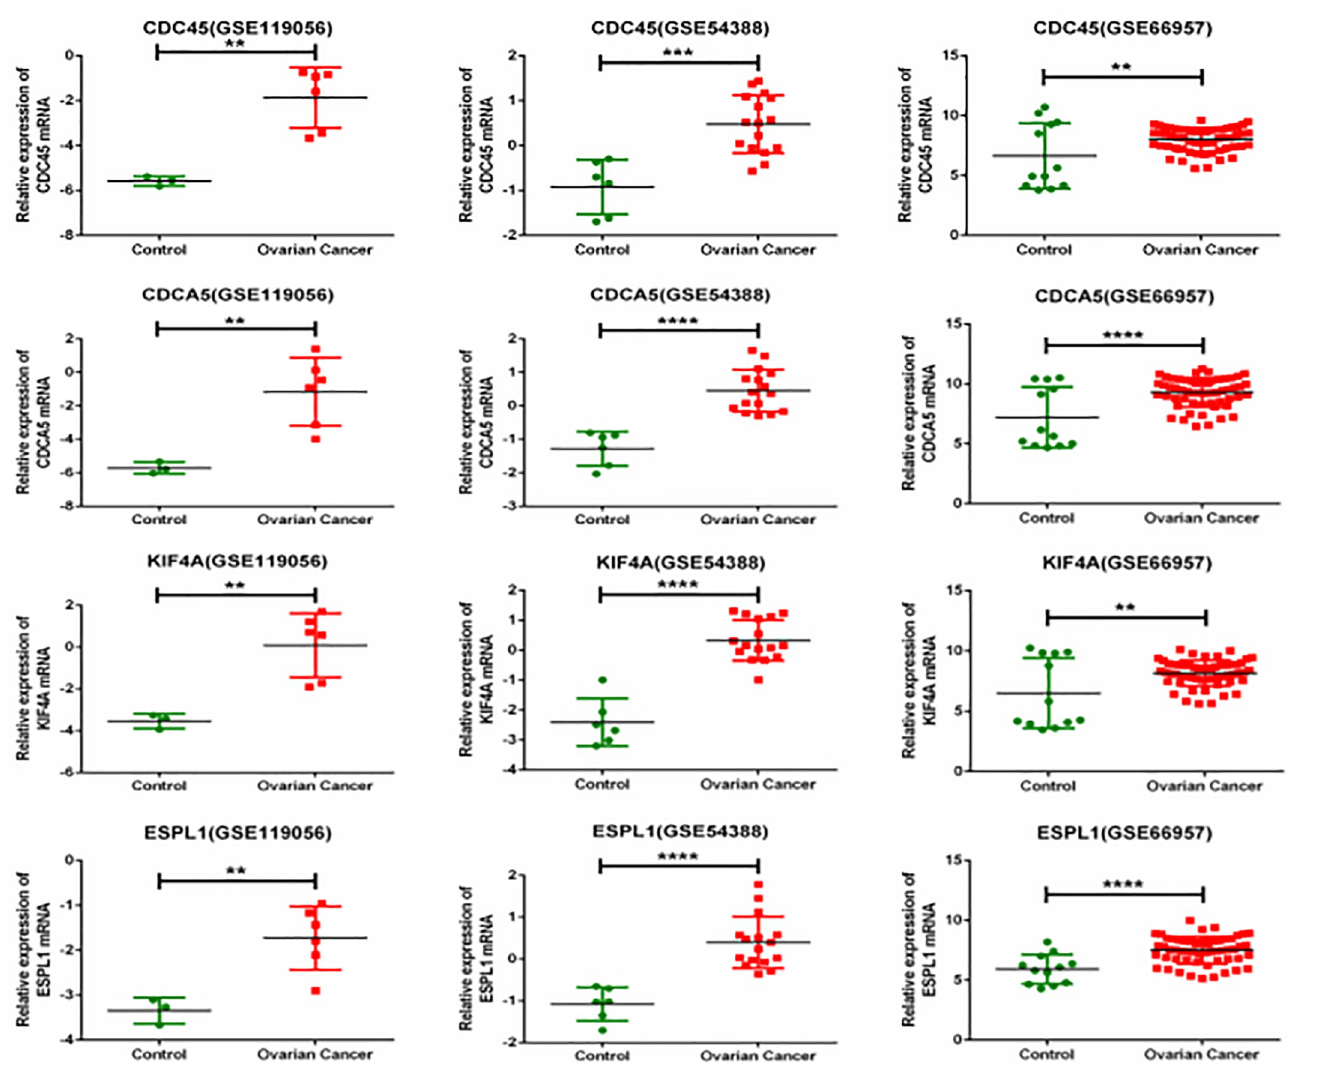
Fig 4. Validation of hub gene expression levels in GEO. The expression of CDC45, CDCA5, KIF4A, and ESPL1 in EOC tissues were significantly elevated compared with adjacent ovarian tissues. (a) CDC45; (b) CDCA5; (c) KIF4A; (d) ESPL1; � p < 0.05.